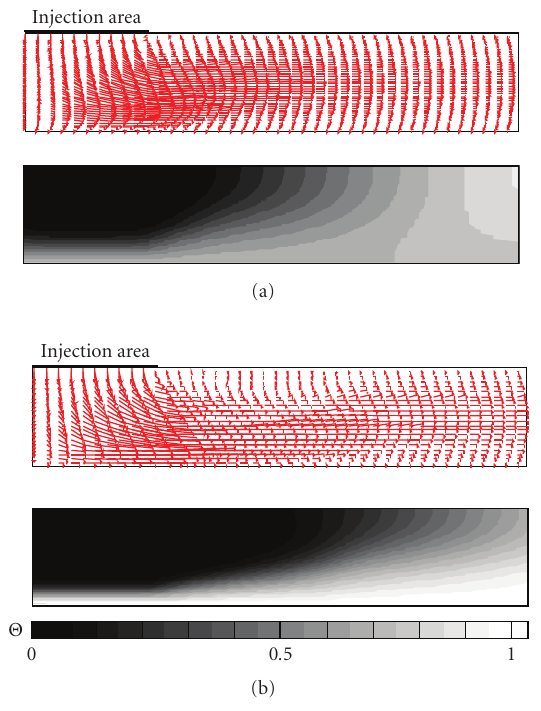
Figure 4: Velocity and temperature distributions in stationary disk at h/D i = 0 . 10, (a) Re = 360, (b) Re = 2000. narrow channel, there is no e ff ect of disk rotation on heat transfer rate on its plate. On the contrary, the heat transfer rate is intensified by the disk rotation for the channel with the wide distance, as seen in Figure 5(b). The corresponding numerical results in the r − z cross-section of the disk are illustrated in Figures 6 and 7 at h/D i = 0 . 05 and 0.10, respectively. (a) and (b) in each figure correspond to the results of the velocity and thermal distributions, respectively. It is observed that the velocity and thermal fields